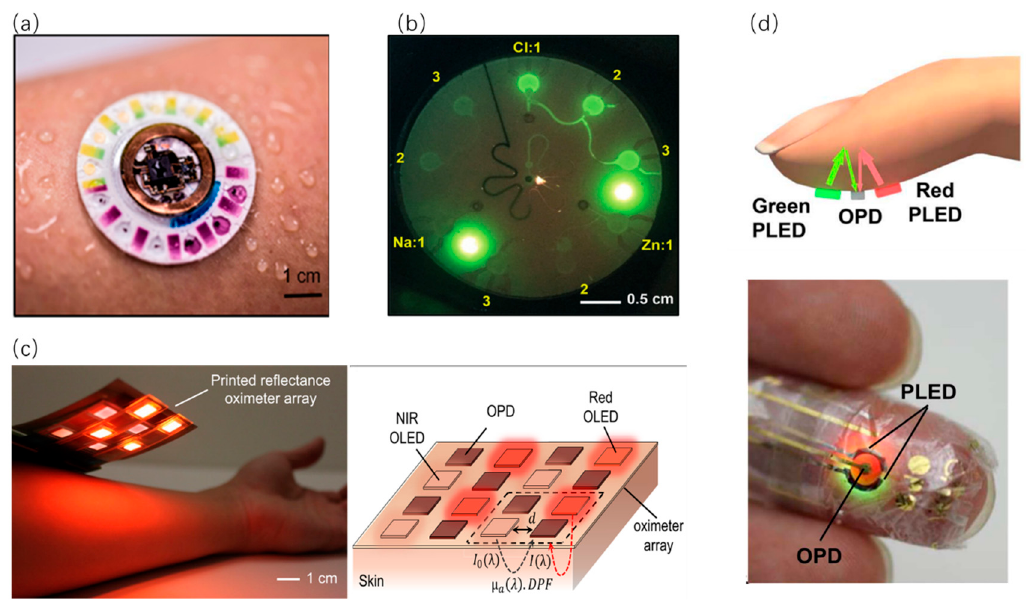
Figure 7. Integrated wearable optical device. ( a ) Image of the device during sweating. Reprinted with permission from [76]. Copyright 2019, AAAS. ( b ) Image of the fluorometric microfluidic device emitted by blue light. Reprinted with permission from [78]. Copyright 2018, RSC. ( c ) Left: Image of reflectance oximeter array (ROA) when in operation. Right: ROA sensor configuration. Red and NIR organic light-emitting diodes (OLED) arrays composed of 2 × 2 pixels each are placed side by side, where the pixels are arranged in a checkerboard pattern. The OPD array composed of 8 pixels is placed on top of the OLED arrays. Reprinted with permission from [80]. Copyright 2018, PNAS. ( d ) Photograph of a finger with the ultra-flexible organic optical sensor attached. Reprinted with permission from [81]. Copyright 2016, AAAS.